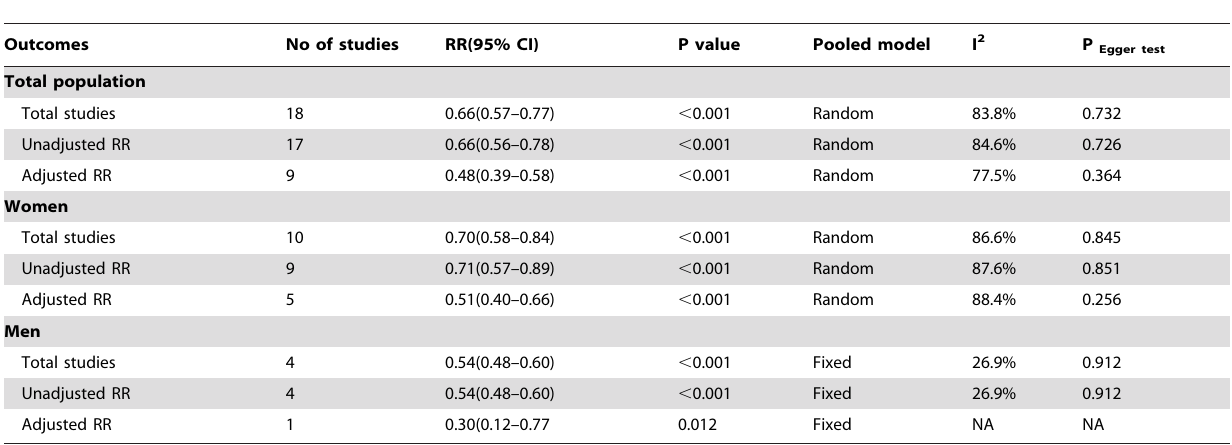
Table 2. Summary of the results in the meta-analysis of adult obesity and risk of hip fracture.